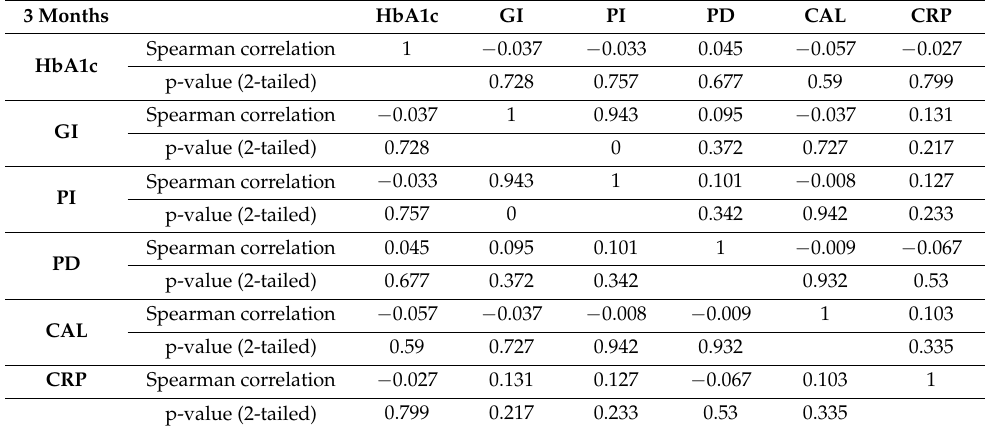
Table 4. Correlation and significance analysis between all variables of the intervention group at 3